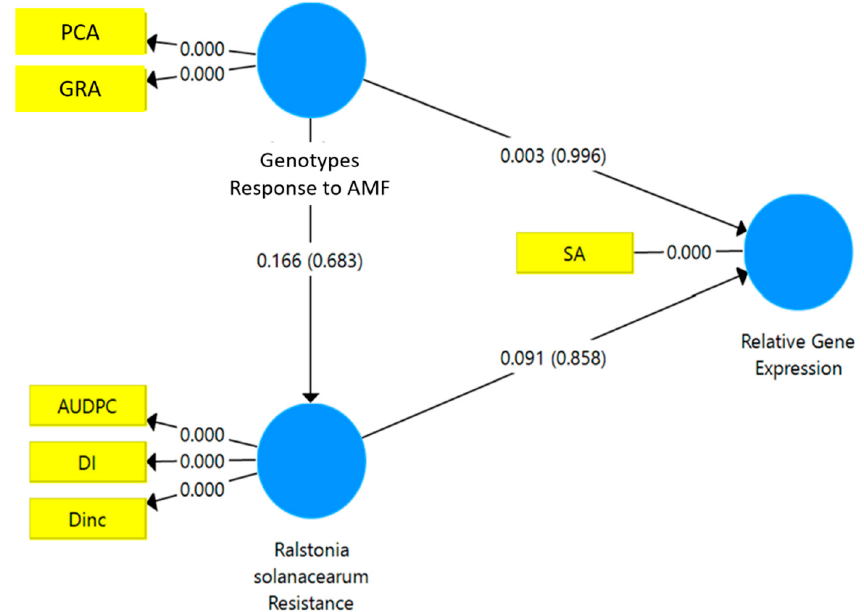
Figure 5. Structural equation modeling-partial least square (SEM-PLS) of the relationship between the responsiveness to mycorrhizae and the resistance of the tropical chili pepper genotypes to R. solanacearum variables and the relative gene expression of SA. AMF: arbuscular mycorrhizal fungi. PCA: percentage colonization of mycorrhizae, GRA: the growth response of the tropical chili pepper genotypes to mycorrhizae, DI: disease intensity, DInc.: disease incidence, AUDPC: area under disease progress curve, SA: salicylic acid.